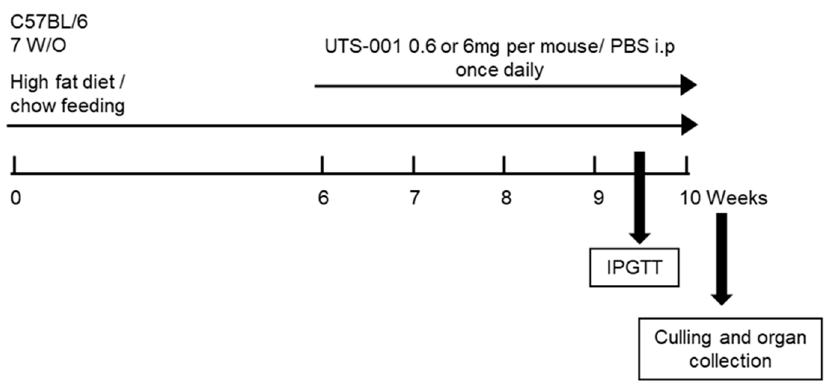
Figure 8. Schematic diagram of animal experiments.